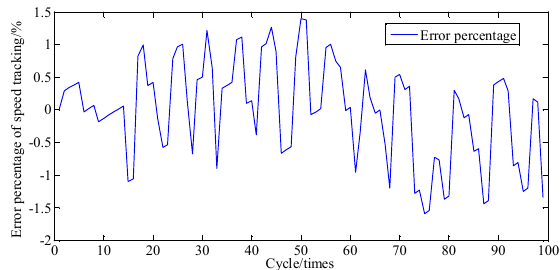
Figure 15. Error percentage of speed tracking at A / F ratio 0.95.